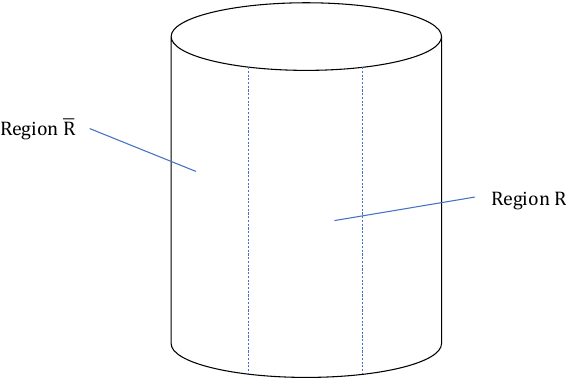
Figure 5 . A vertical slit on a